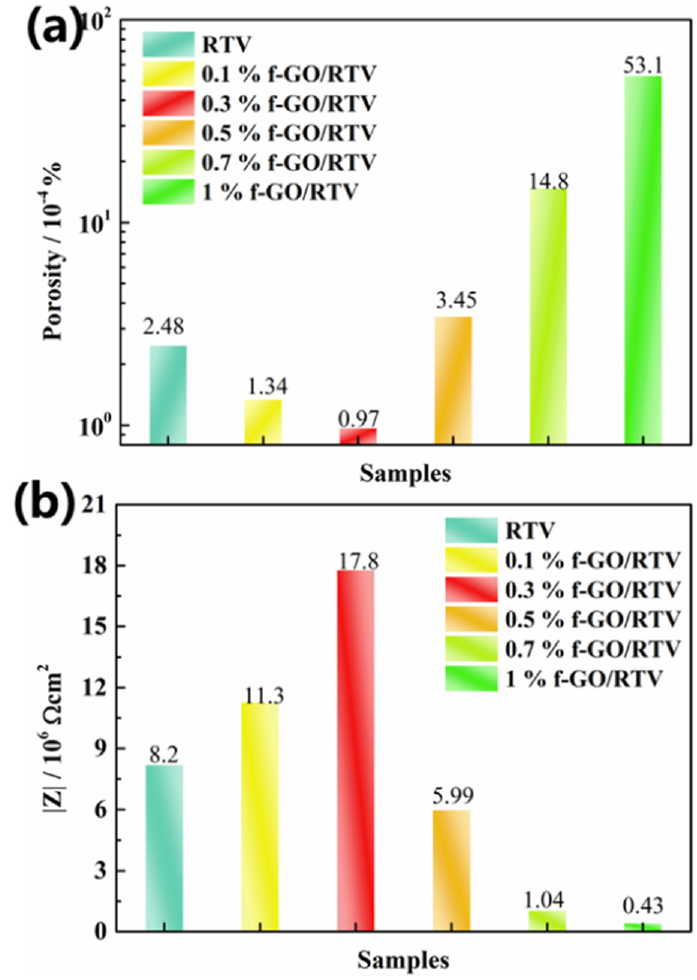
Figure 10. Variations in porosity ( a ) and impedance modules (|Z| at 0.1 Hz) ( b ) of RTV nanocom- posite coatings filled with different filler content of f-GO nanosheets after NO 2 oxidation.